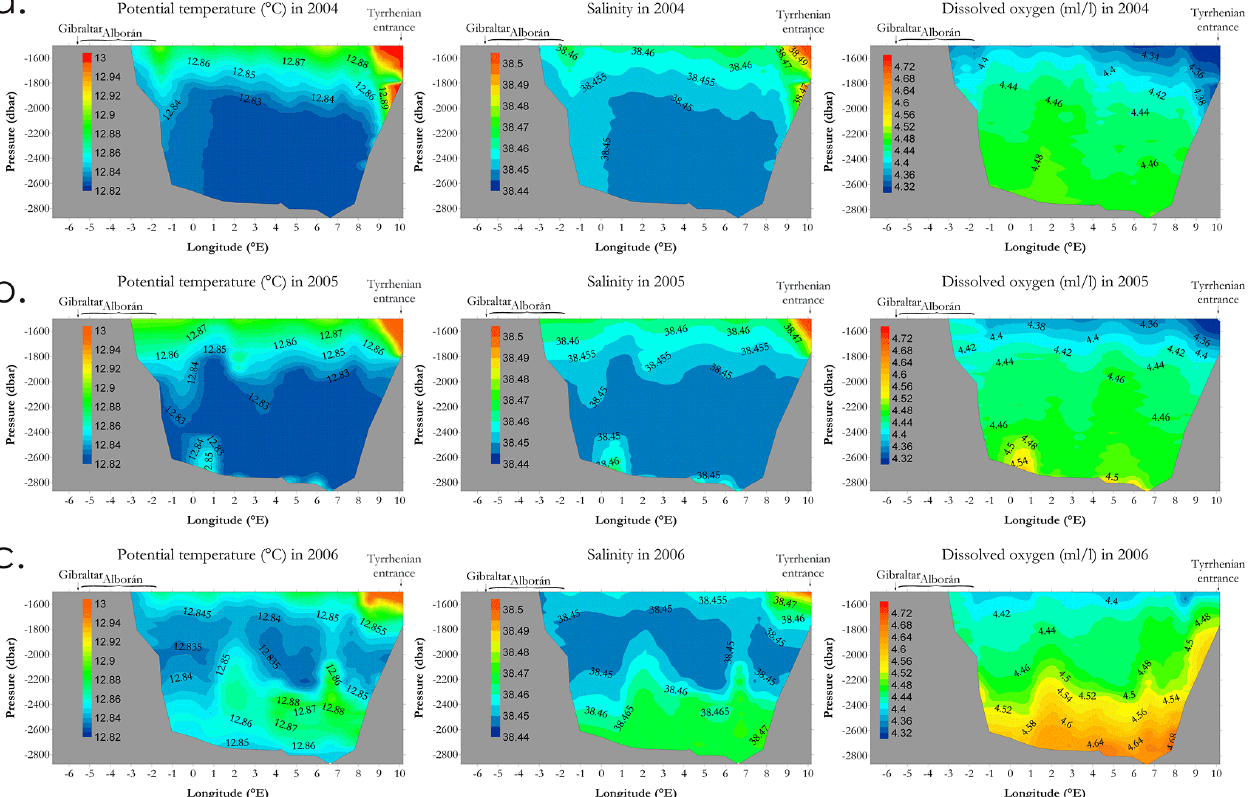
Fig. 9. Vertical θ , S and O 2 distributions below 1500m depth along transects in the WMed showing the evolution of the WMT.